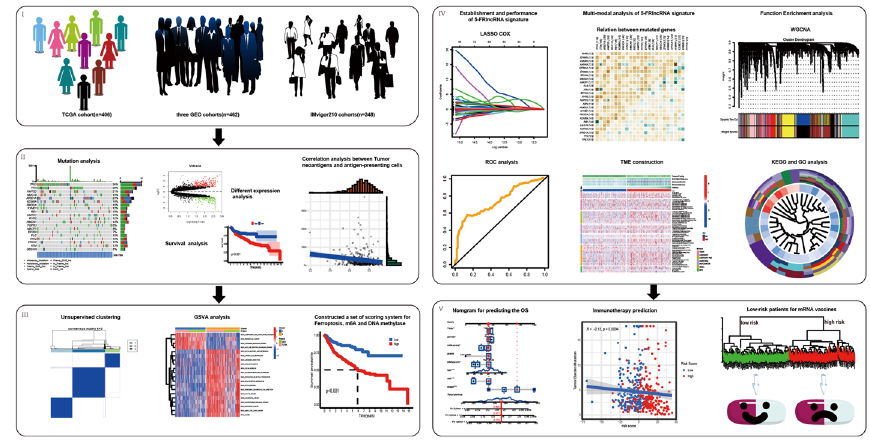
Fig. 1 The flow chart of the study